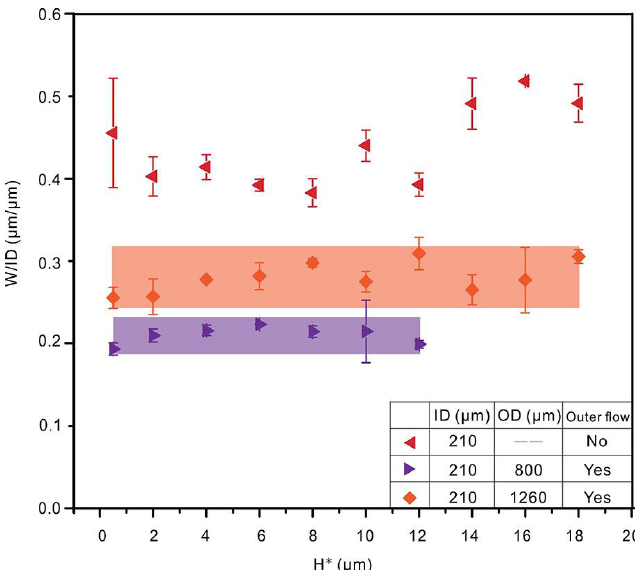
Figure 5. Trace widths normalized by ID as a function of H* and 95% confidence interval of widths printed by CNINE. A uniaxial nozzle and two CNINE with different outer channel diameters were used for the study (Q ID = 8 μL/min, V P = 40 mm/s). H* is the relative distance between the outlet of coaxial nozzle and its baseline (H* = H − 5 μm).